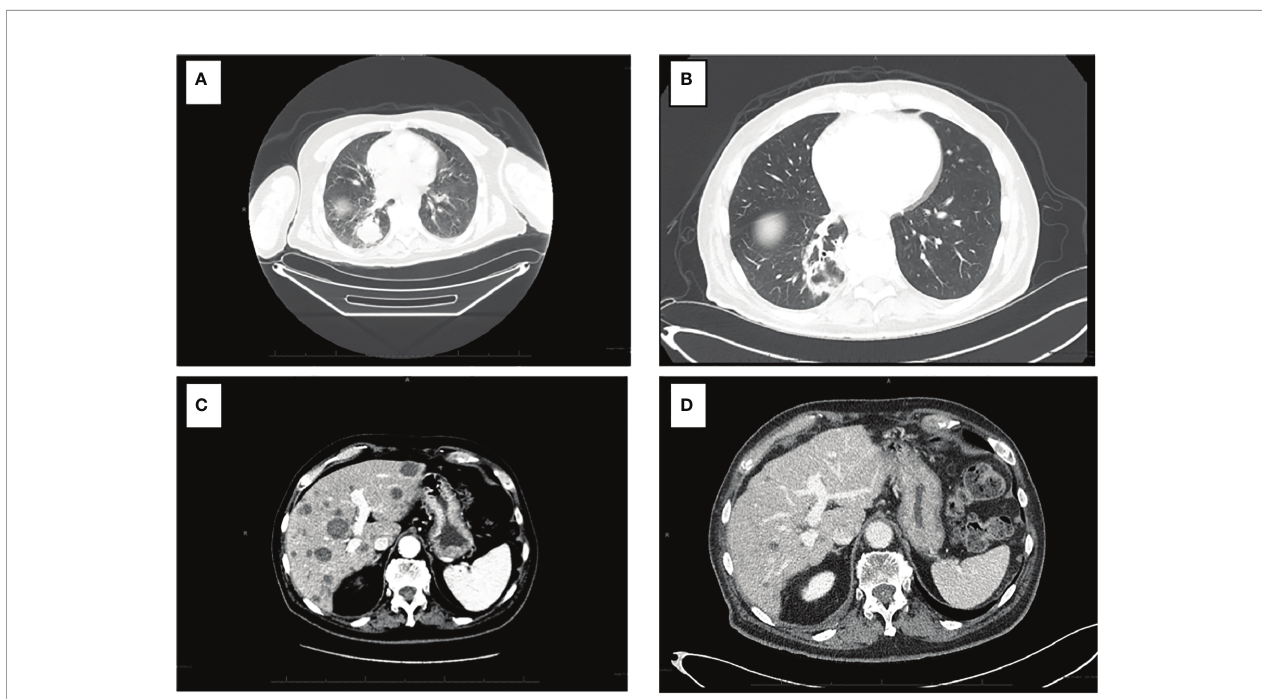
FIGURE 3 | CT of the chest and abdomen pre and post treatment with combination nibolumab and ipiliimumab. (A) Intrathoracic lymphadenopathy anf right lower lobe lung nodule. (B) Interval resolution of intrathoracic lymphadenopathy and right lower lung nodule. (C) Numerous hepatic metastasis and retroperitoneal lymphadenopathy with the largest hepatic lesion measuring 3.7 cm. (D) Resolution of retroperitoneal lymphadenopathy and marked interval decrease size of hepatic metastasis with lesion now measuring 1.7